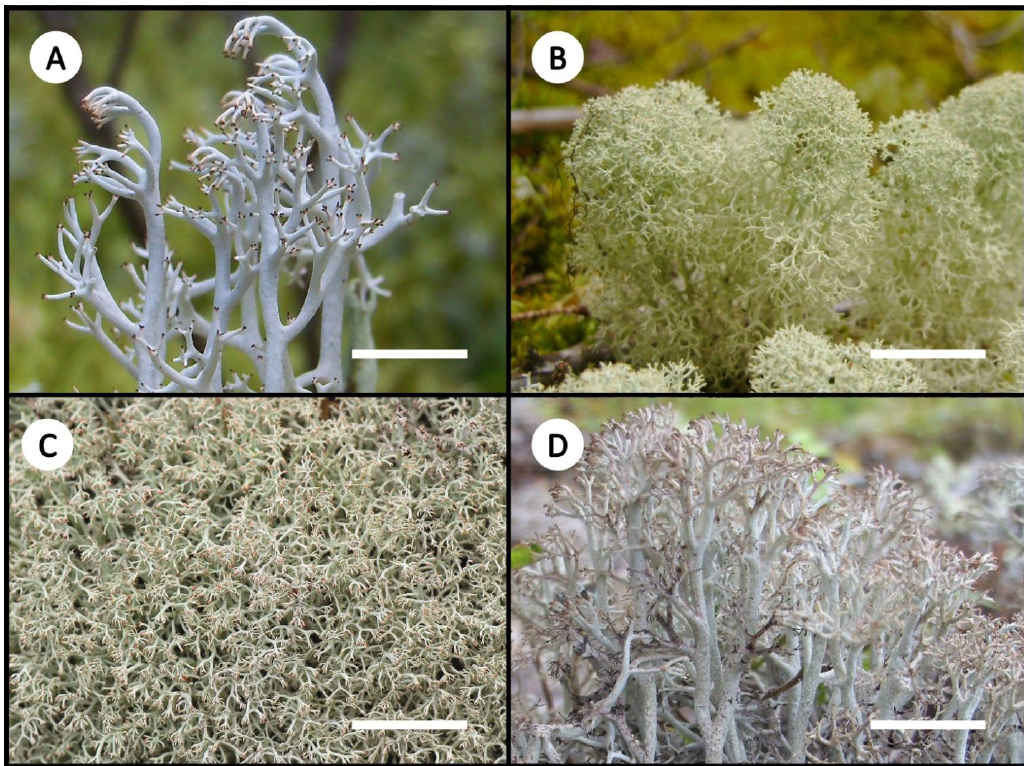
Figure 1. Common reindeer lichen. A) Cladonia rangiferina , scale = 0.4 cm. B) Cladonia stellaris , scale = 1 cm. C) Cladonia mitis , scale = 1.2 cm. D) Cladonia stygia , scale = 0.6